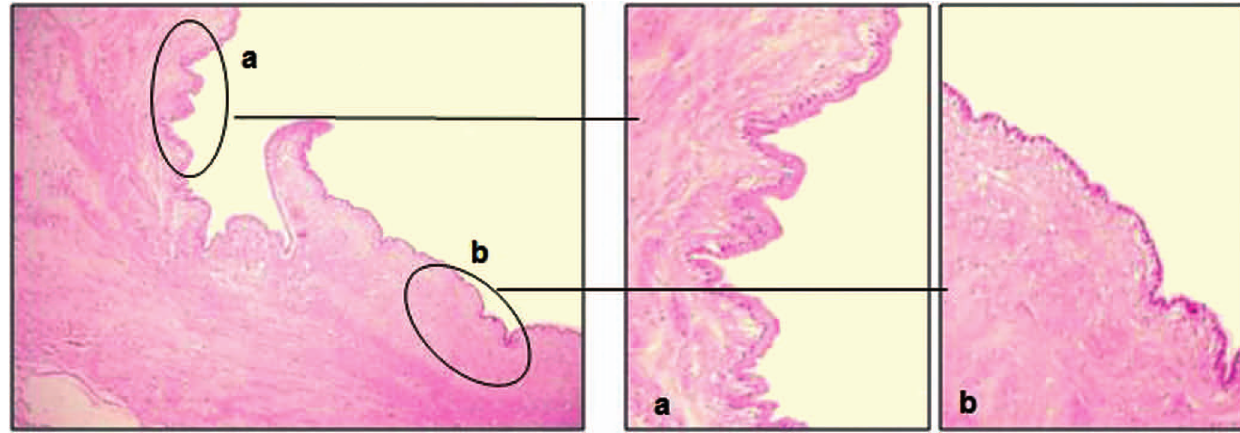
Fig. 3. Histological section of piapara Leporinus obtusidens swimbladder with sac-like projection (HE staining, 10x). a ) hypertrophy and hyperplasia in the inner epithelium of the sac-like projection; b ) normal cells in the inner swimbladder